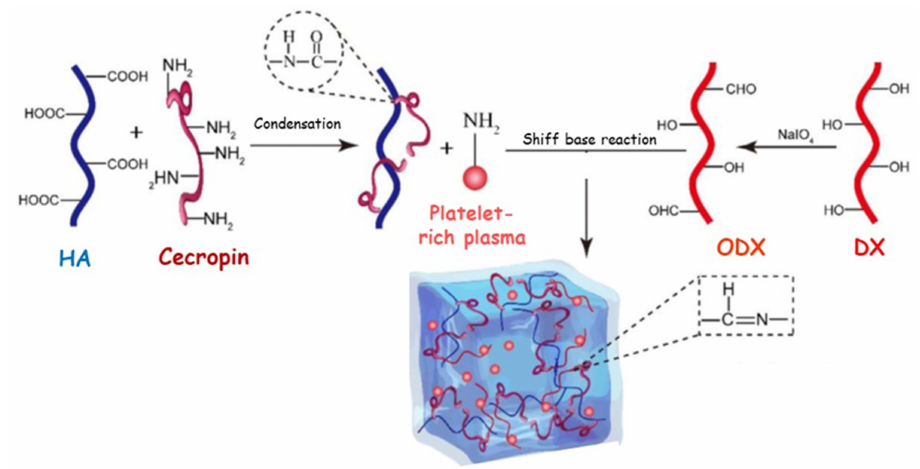
Figure 6. Schematic illustration of the synthesis of Hyaluronic acid (HA)-Cecropin and Oxidized dextran (ODX) and their crosslinking reaction to fabricate ODX/HA-Cecropin/Platelet rich plasma hydrogel [119].